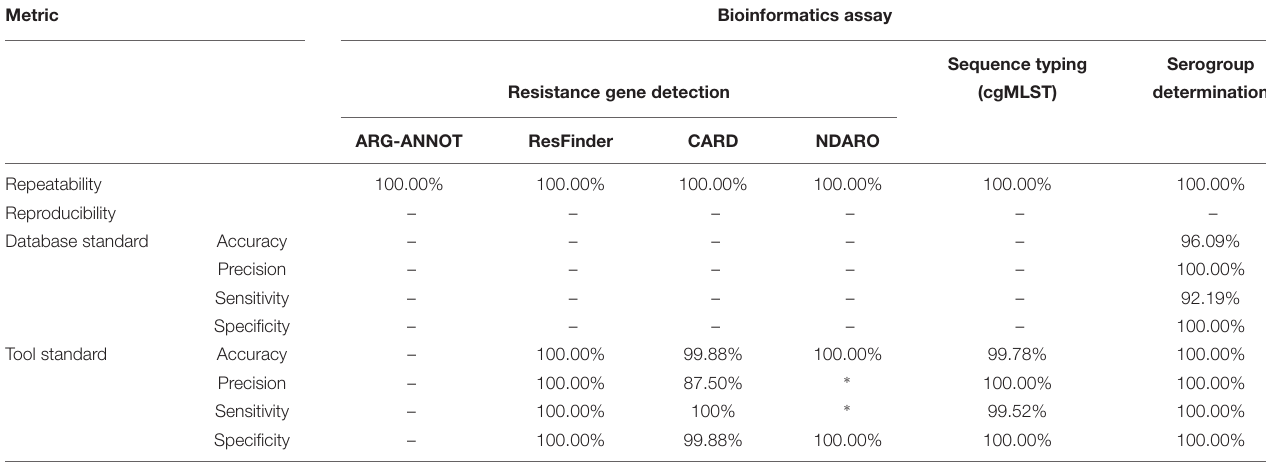
TABLE 5 | Results for the extended validation